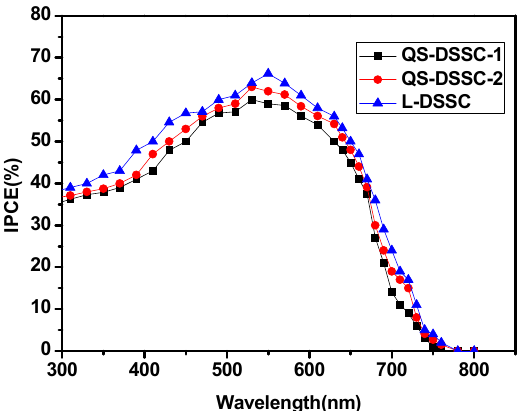
Figure 10. IPCE spectra of the DSSCs with quasi-solid-state electrolytes based on the electrospun PVDF nanofiber membranes and ionic liquid electrolyte.